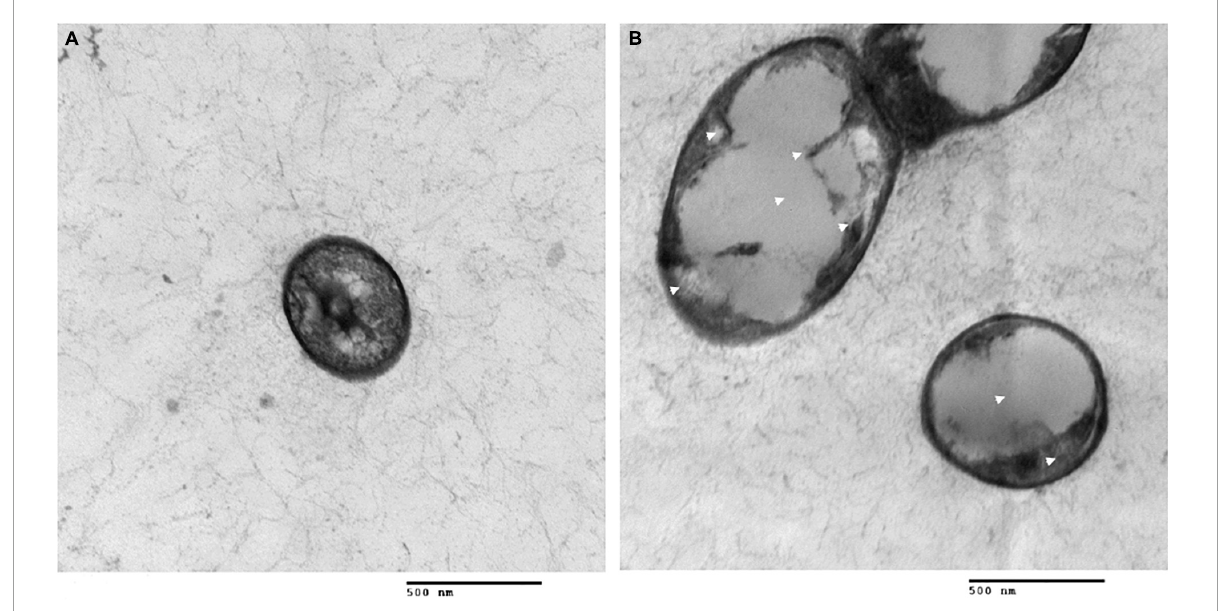
FIGURE7 Transmission electron micrographs of S. scabies treated with Lcn972. (A) without Lcn972; (B) with Lcn972.